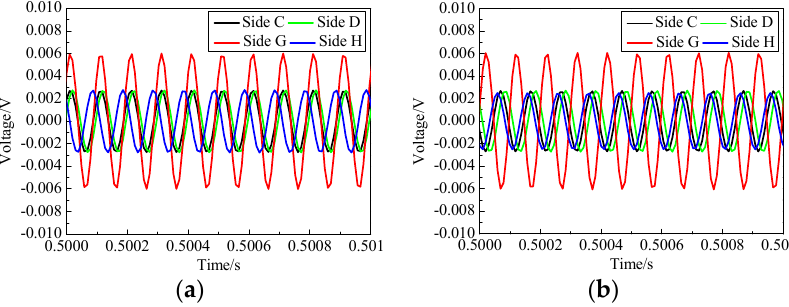
Figure 11. Voltage signals measured by the sensors in the first and third columns on Sides C, D, G and H. ( a ) Measurements on the first column; ( b ) measurements on the third column.